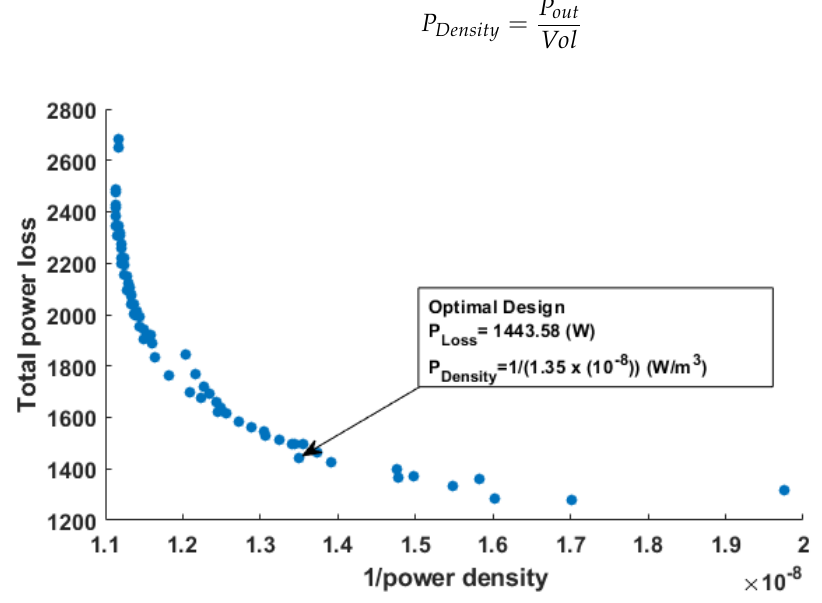
Figure 3. Optimization results for the design of the surface PMSM with hairpin winding. Table 2. Design summary of the PMSM and comparison versus the previous design [12].